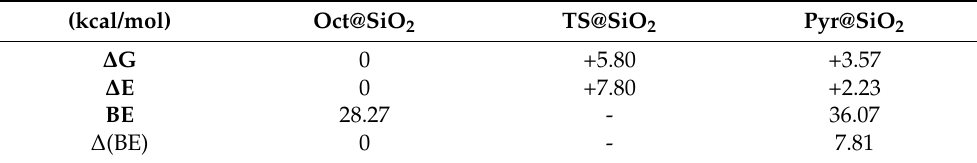
Table 3. Free energy differences ΔG and energy differences ΔE for the transition state and Pyr with respect to Oct. Binding energies BE (kcal/mol) of the octahedral (Oct) and pyramidal (Pyr)